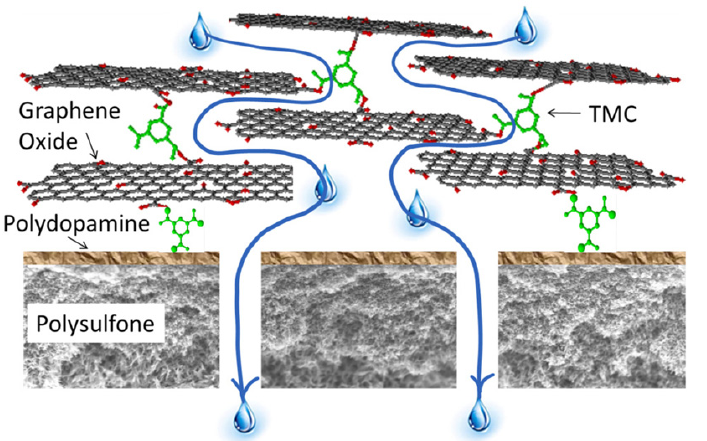
Figure 18. Schematic illustration of a step-by-step procedure to synthesize the GO membrane, the mechanism of reactions between PDA and TMC, and the mechanism of reactions between GO and TMC. Reproduced with permission from [178], copyright of American Chemical Society.